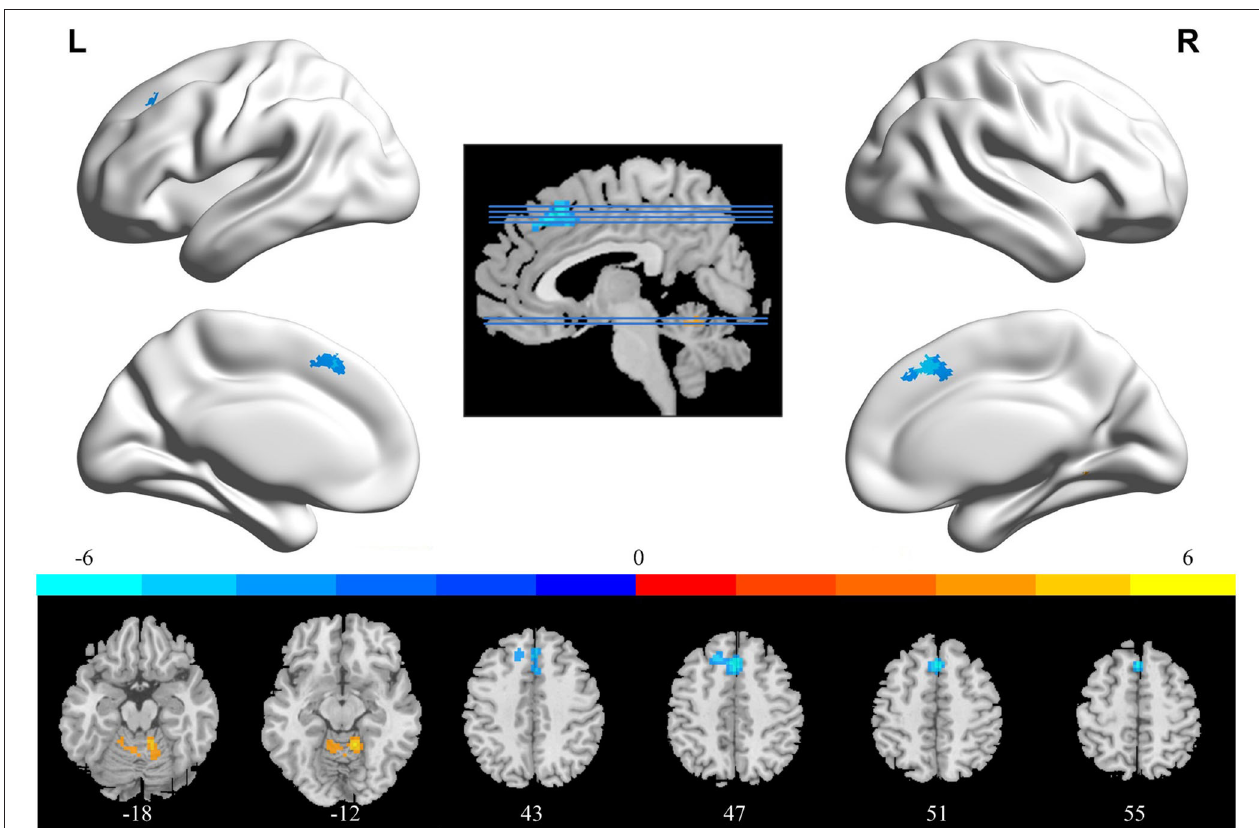
FIGURE 2 | Brain areas that exhibited altered ReHo induced by real-time fMRI neurofeedback training (after training vs. before training). Results were set at voxel-level P < 0.001, cluster-level P < 0.05, and t = 3.29 (Gaussian random field corrected). Warm colors indicate regions in which ReHo increased significantly, whereas cool colors indicate regions in which ReHo decreased significantly. The color bar indicates the t -value. The numbers at the bottom indicate the axial slices. ReHo, regional homogeneity; L, left; R,